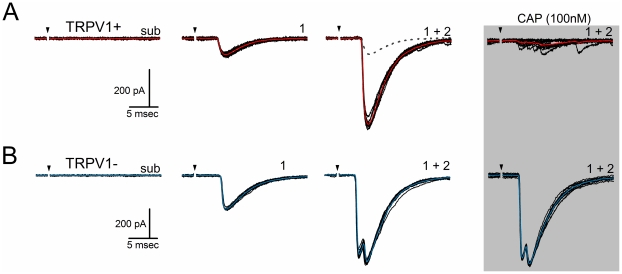
Convergent ST afferent inputs are either capsaicin sensitive or resistant.
A) In most cases, increases in shocks to the ST recruited more than one afferent (1+2) to produce a compound EPSC (broken line depicts the low threshold EPSC 1 for comparison). Addition of the TRPV1 agonist capsaicin (100 nM) blocked the synchronous, high intensity compound EPSCs (1+2, gray shaded box). In such TRPV1+ neurons, CAP increased the number of baseline stochastic EPSCs despite blocking ST synced events. B) In other neurons, CAP had no effect on the synaptic response to ST activation of two convergent ST axons and thus was considered TRPV1−. Current traces are 5 sweeps superimposed, stimulus artifacts removed. The colored trace is the average waveform.